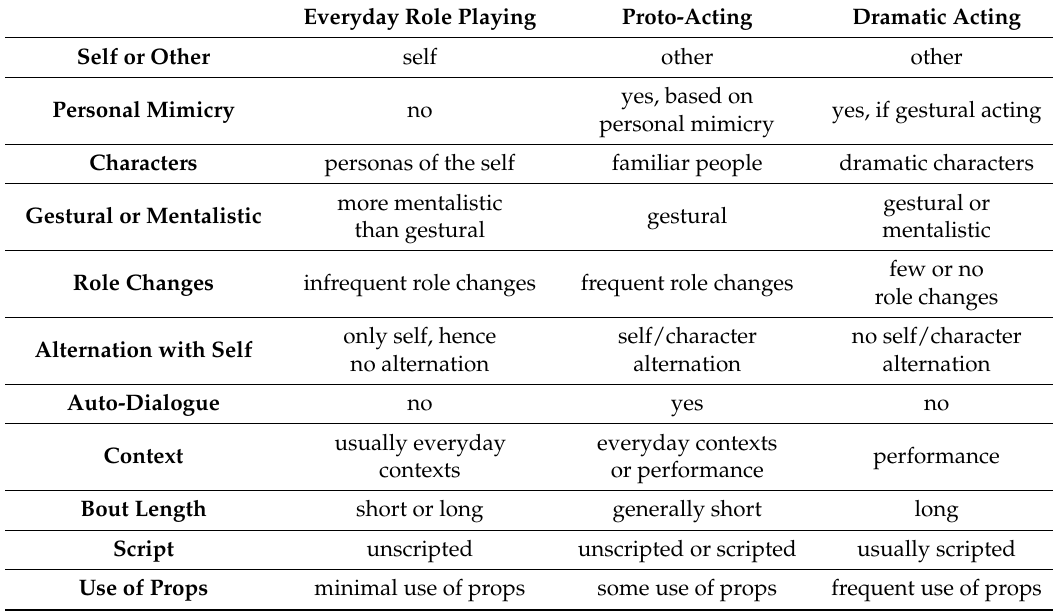
Table 1. Proto-acting in comparison to everyday role playing and dramatic